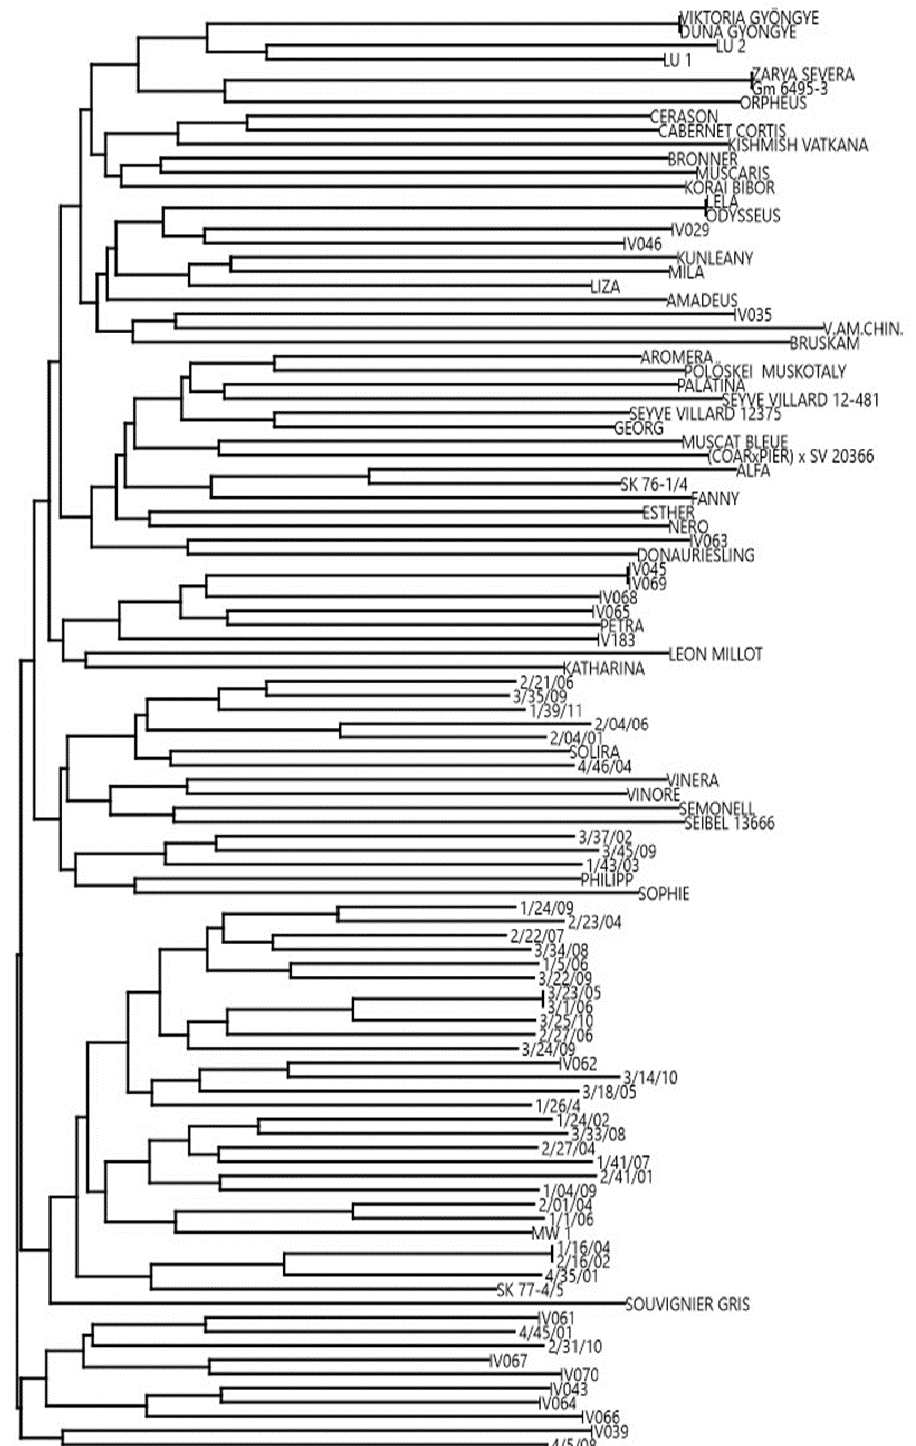
Figure 1. Dendrogram showing the genetic distance based on cluster analysis (Neighbour Joining clustering; Euclidean similarity).